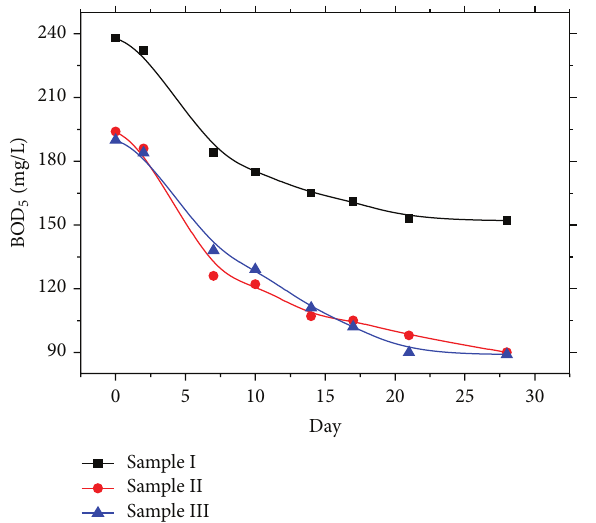
Figure 6: The adsorption-desorption isotherms of sample